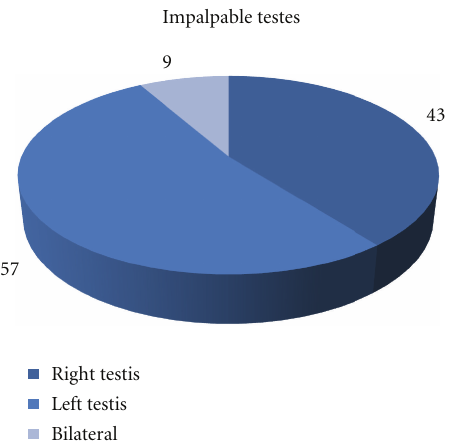
Figure 3: Distribution of impalpable testes according to the side a ff